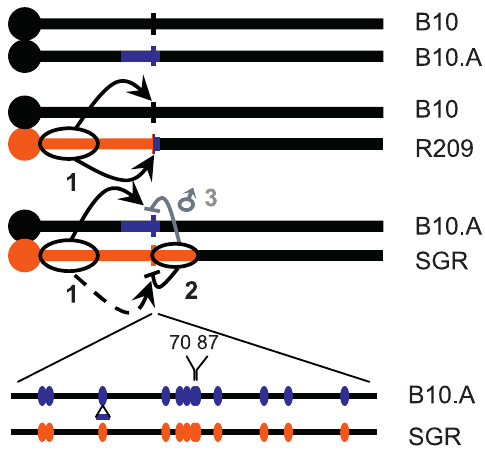
Figure 5. Genetic Control in Cis and in Trans of Meiotic Recombination at the Psmb9 Hotspot 1, wm7 -specific trans -acting activator; 2, cis -acting repressor specific for SGR chromosome; 3, sex-specific control in trans of the recombination